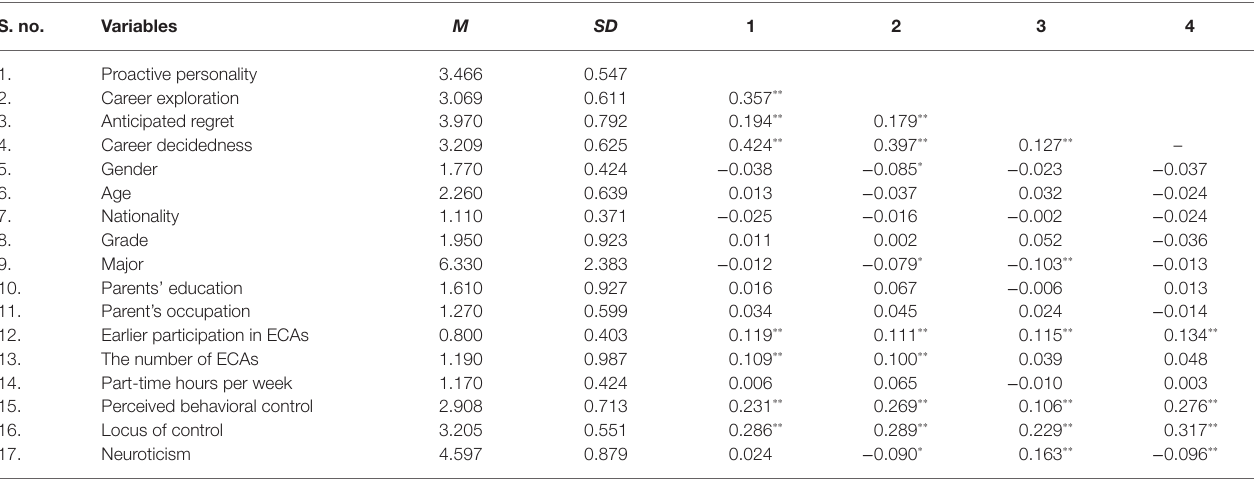
TABLE 2 | Descriptive statistics and correlations of study